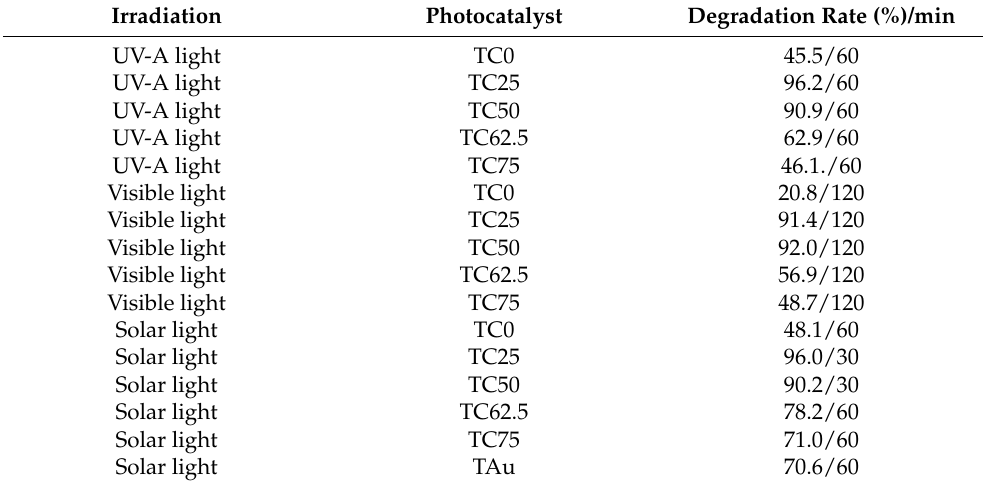
Table 3. Methyl orange degradation efficiency per time for C-modified titanium dioxide (TC) in a binder for coating cementious mortars under UV, visible, and sunlight irradiation. Different ratios of C-dots in contact with titania are presented (TC0: no C-dots; TC75: high loading). TAu means titania in contact with Au. (Reprinted/adapted with permission from Ref.